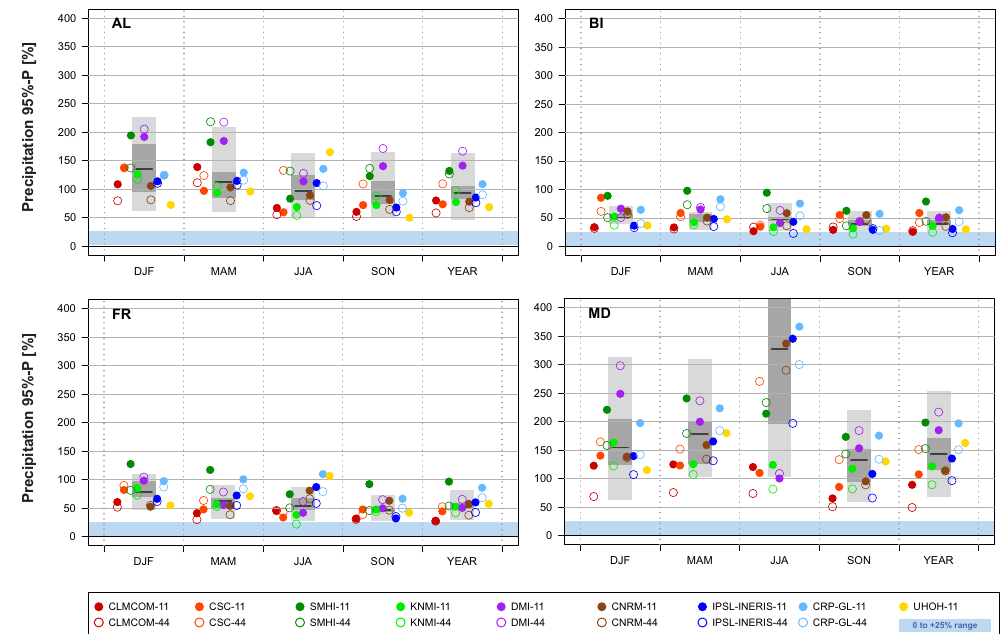
Figure B4. As Fig. B3 but for the 95th percentile of mean seasonal and annual relative precipitation biases (absolute values; 95%-P; %). The blue shading indicates a bias range between 0 and + 25%, corresponding to acceptable wet model biases in case of a systematic rain gauge undercatch of up to 20% of true precipitation. See Fig. 8 for subdomains EA, IP, ME and